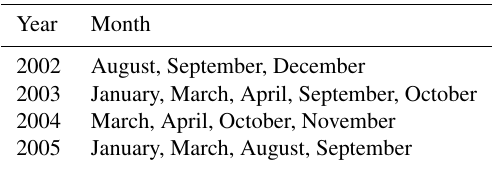
Table 6. The operational periods of used ASPeCt data in this